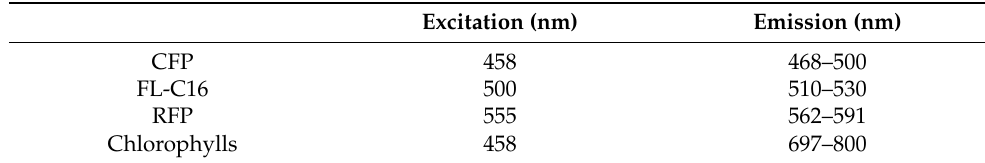
Table 1. The optical